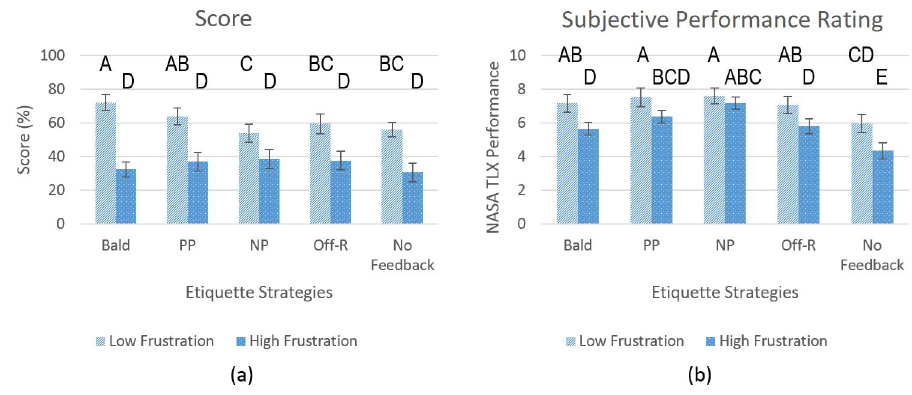
Figure 4. Mean and standard error of ( a ) problem score and ( b ) NASA task load index (TLX) performance ( n = 40).